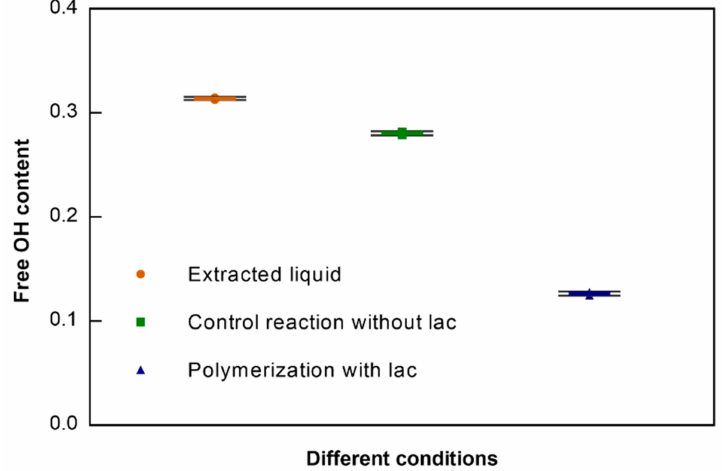
Figure 2. The total content of free OH groups on the extracted liquid and reaction mixtures (data after polymerization of the extracted liquid after the 1st boiling, all the data presented are the mean of 3 repetitions).